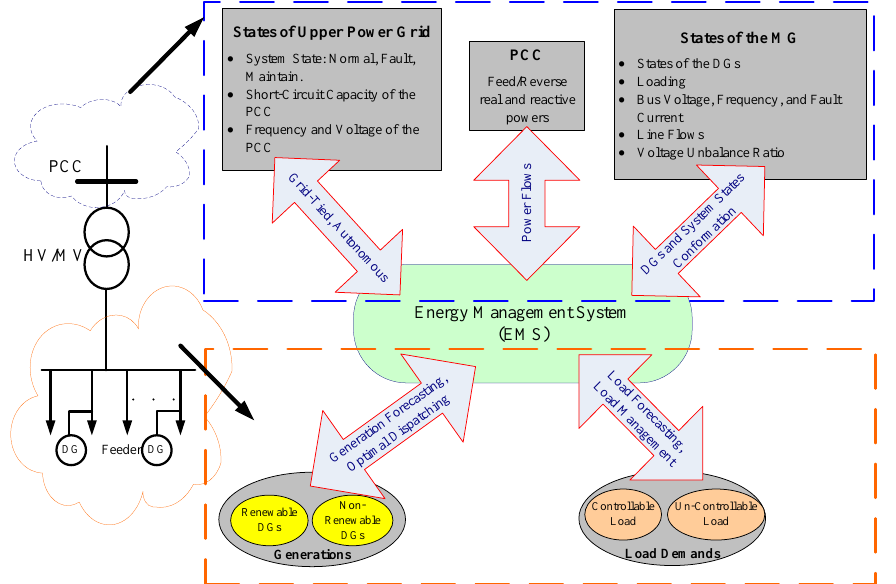
Figure 3. Functions of EMS. PCC: point of common